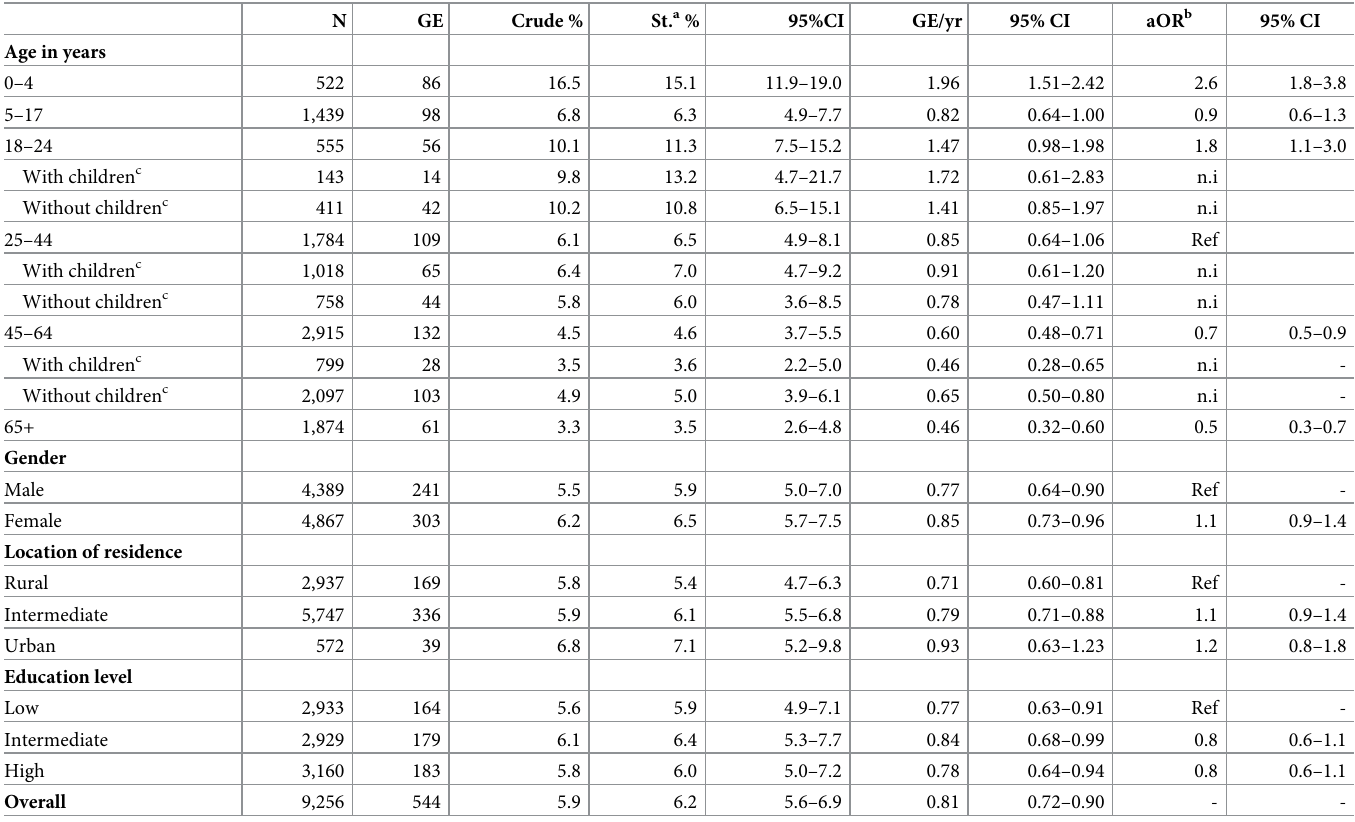
Table 1. Incidence of gastroenteritis per person-year by sociodemographic variables in the general population in the Netherlands, November 2014 to November 2016. N